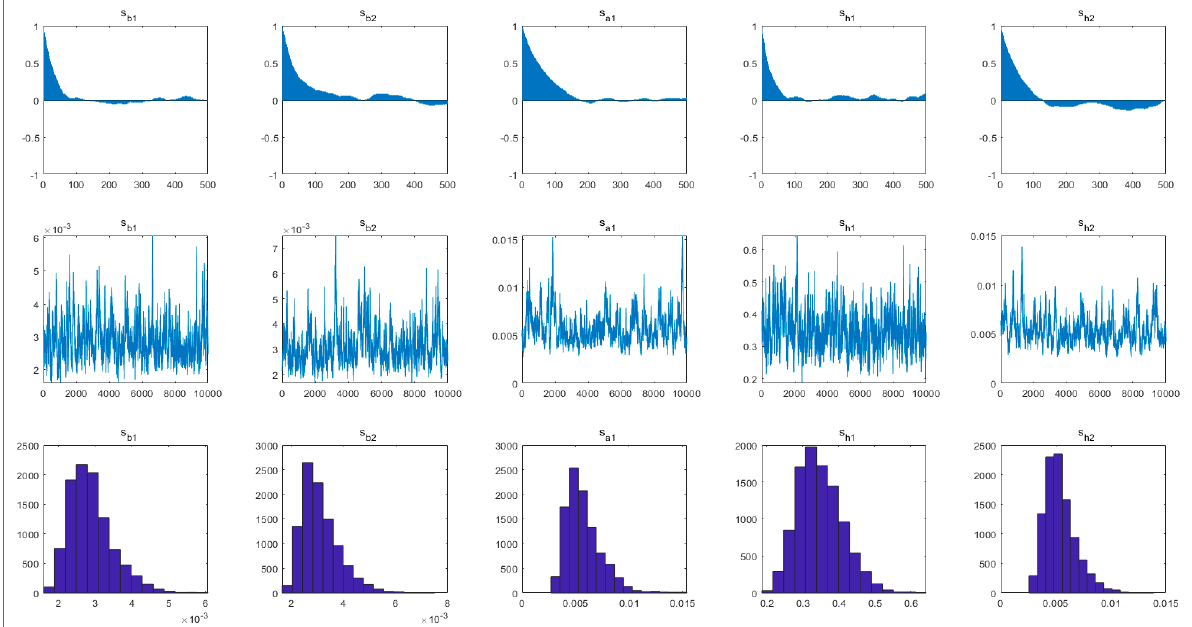
Figure 4. Post-distribution of Gibbs sampling (based on Korea Real Estate Board Price Index) . Note: the first line graph shows the autocorrelation; the second shows the sample path; and the third shows the posterior distribution density. Source: estimated by the authors with the TVP-VAR model.